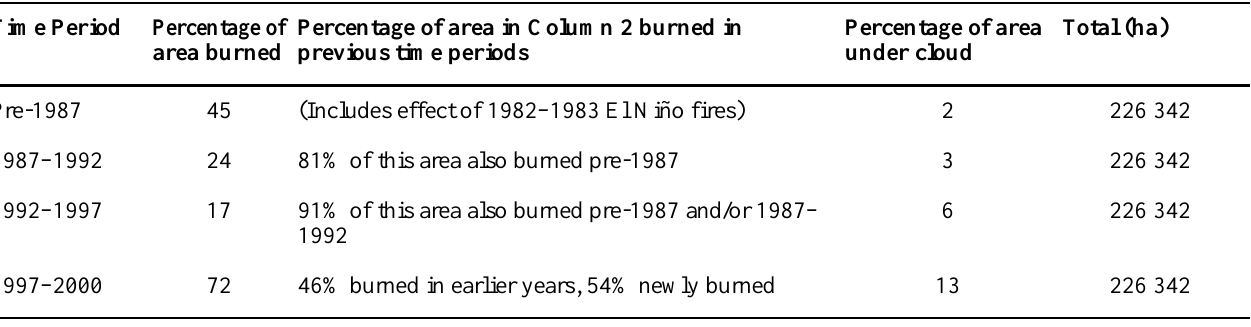
Table 1. Estimated percentage of area burned in each of four time periods in the Middle Mahakam study site Time Period Percentage of Percentage of area in Column 2 burned in area burned previous time periods